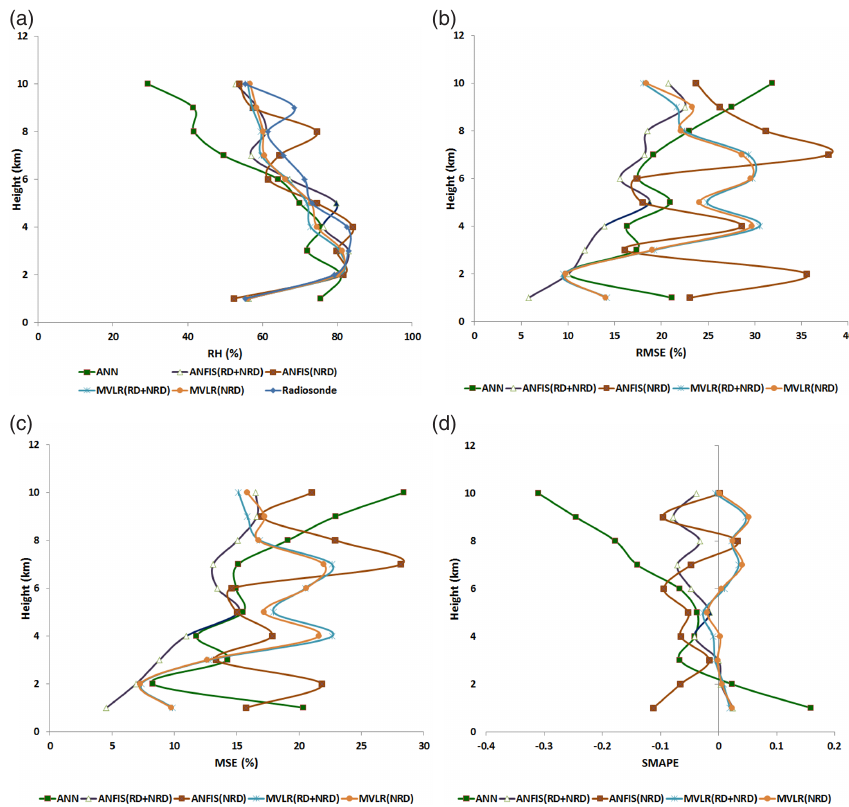
Figure 6. Comparison of vertical profiles of (a) RH observed by radiosonde and temperature profiles retrieved from ANN AN- FIS(RD + NRD), ANFIS(NRD), MVLR(RD + NRD) and MVLR(NRD) and (b) RMSE, (c) MAE and (d) SMAPE of retrieved profiles using ANN, ANFIS(RD + NRD), ANFIS(NRD), MVLR(RD + NRD) and MVLR(NRD) with respect to relative humidity profiles observed by